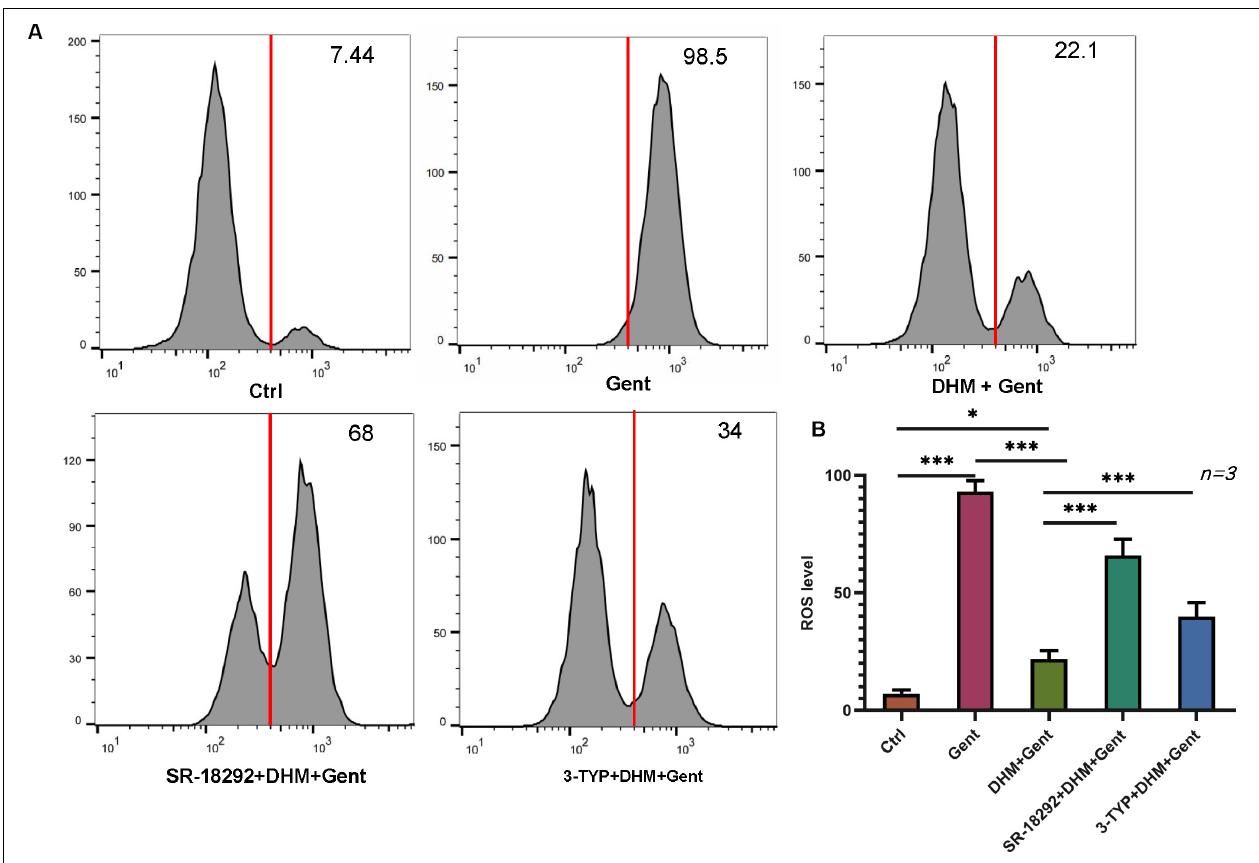
FIGURE 6 | PGC-1 α and SIRT3 mediate the protective effect of DHM against gentamicin-induced oxidative stress in HEI-OC1 cells. (A,B) HEI-OC1 cells were pretreated with PGC-1 α and SIRT3 inhibitors (SR-18292 and 3-TYP, respectively) before treatment with 1 mM DHM followed by 500 µ M gentamicin for 12 h. Intracellular ROS levels were measured by DCFH-DA staining combined with flow cytometry. The experiment was repeated three times. ∗ P < 0.05, ∗∗∗ P < 0.001 (one-way analysis of variance followed by Tukey’s multiple comparisons